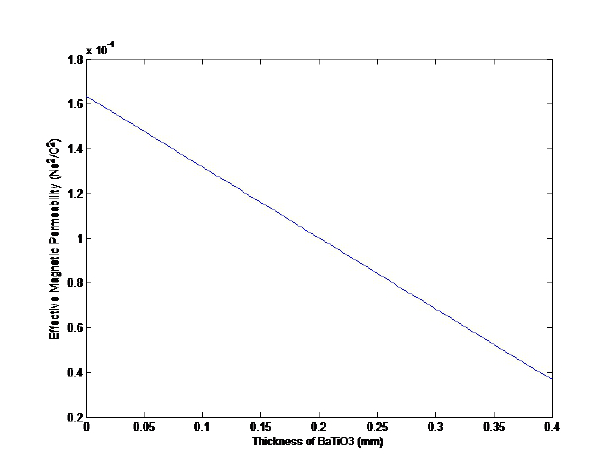
Figure 4: Plot of effective ⟨ 𝛾 11 ⟩ magnetic permeability coeflcient vs. thickness of the BaTiO 3 laminae.